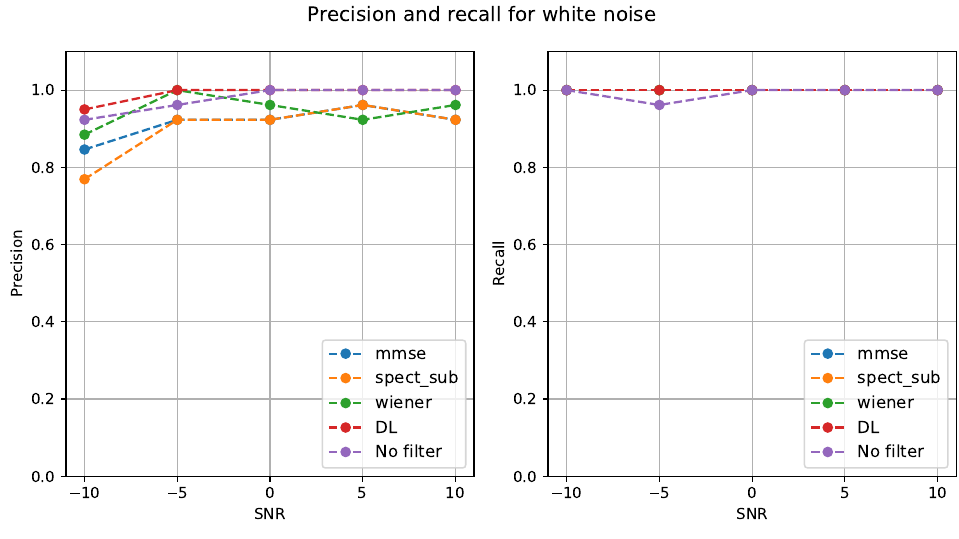
Figure 5. Comparison of Precision and Recall results for White noise.